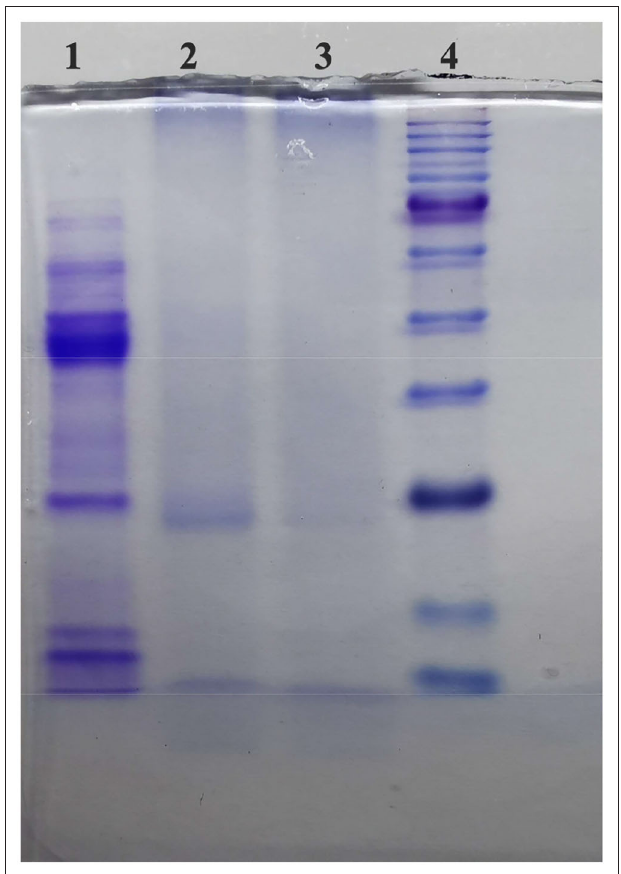
FIGURE 1 | Sodium dodecyl sulfate-polyacrylamide gel electrophoresis (SDS-PAGE) to detect PPO in 2.00 mg/ml theabrownins (TBs-E) (5.00% concentrated gel, 12.00% separation gel, and 70V constant-voltage electrophoresis). Among the lanes, lane 1 refers to polyphenol oxidase (PPO), lanes 2 and 3 refer to the TBs-E, and lane 4 refers to the marker